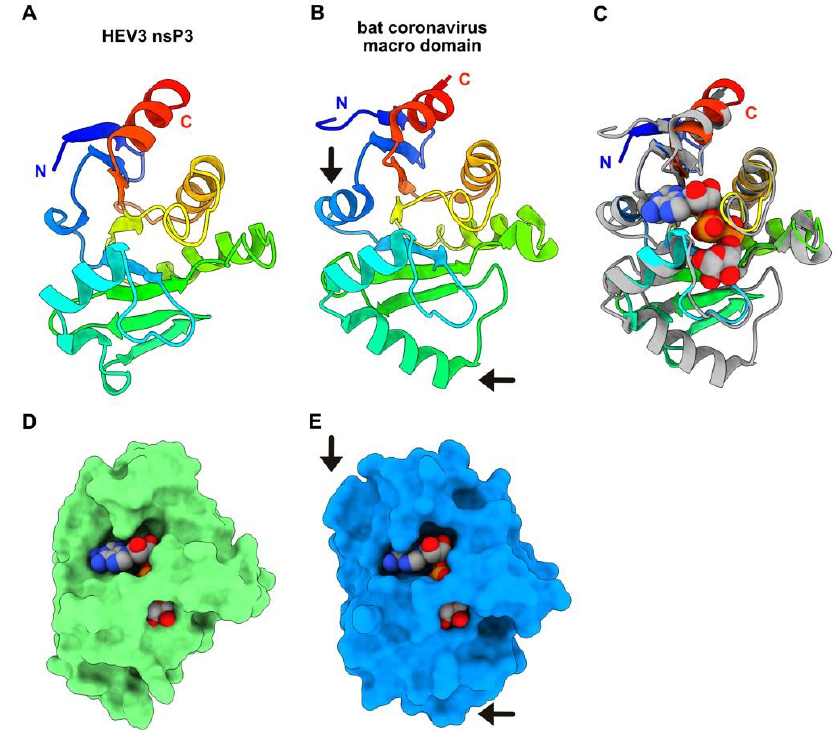
Figure 4. HEV-3 nsP3 predicted structure, a macro domain mono-ADP-ribose hydrolase. ( A ) Ribbon representation of the HEV-3 nsP3 predicted structure (rainbow). ( B ) Ribbon representation of the macro domain of bat CoV-HKU4 (rainbow colored). The arrows point to the position of the two additional helices as compared with HEV-3 nsP3. ( C ) Superimposition of HEV-3 nsP3 (rainbow) with bat CoV-HKU4 macro domain (grey). The ADP-ribose is atom colored and displayed as spheres (C: grey; O: red; N: blue; P: orange). ( D ) Surface representation of HEV-3 nsP3 with the ADP-ribose in the same position as in the bat CoV-HKU4 macro domain, after superimposition of both domains onto each other (panel C). ( E ) Surface representation of bat CoV-HKU4 macro domain in complex with ADP-ribose. The arrows point to the two extra helices as in panel B.